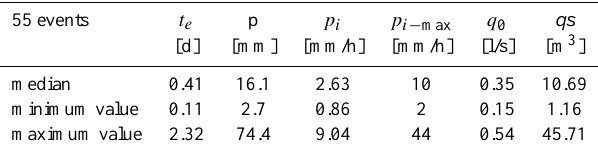
Table 3. Characteristics of the unimodal events measured at the headwater